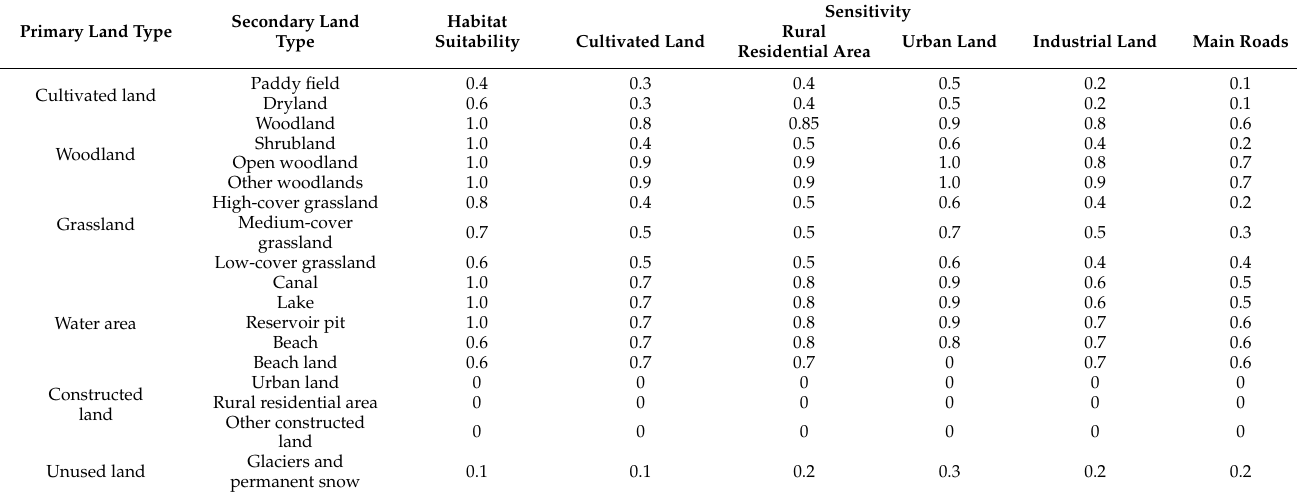
Table 2. Habitat suitability and sensitivity of different types of land